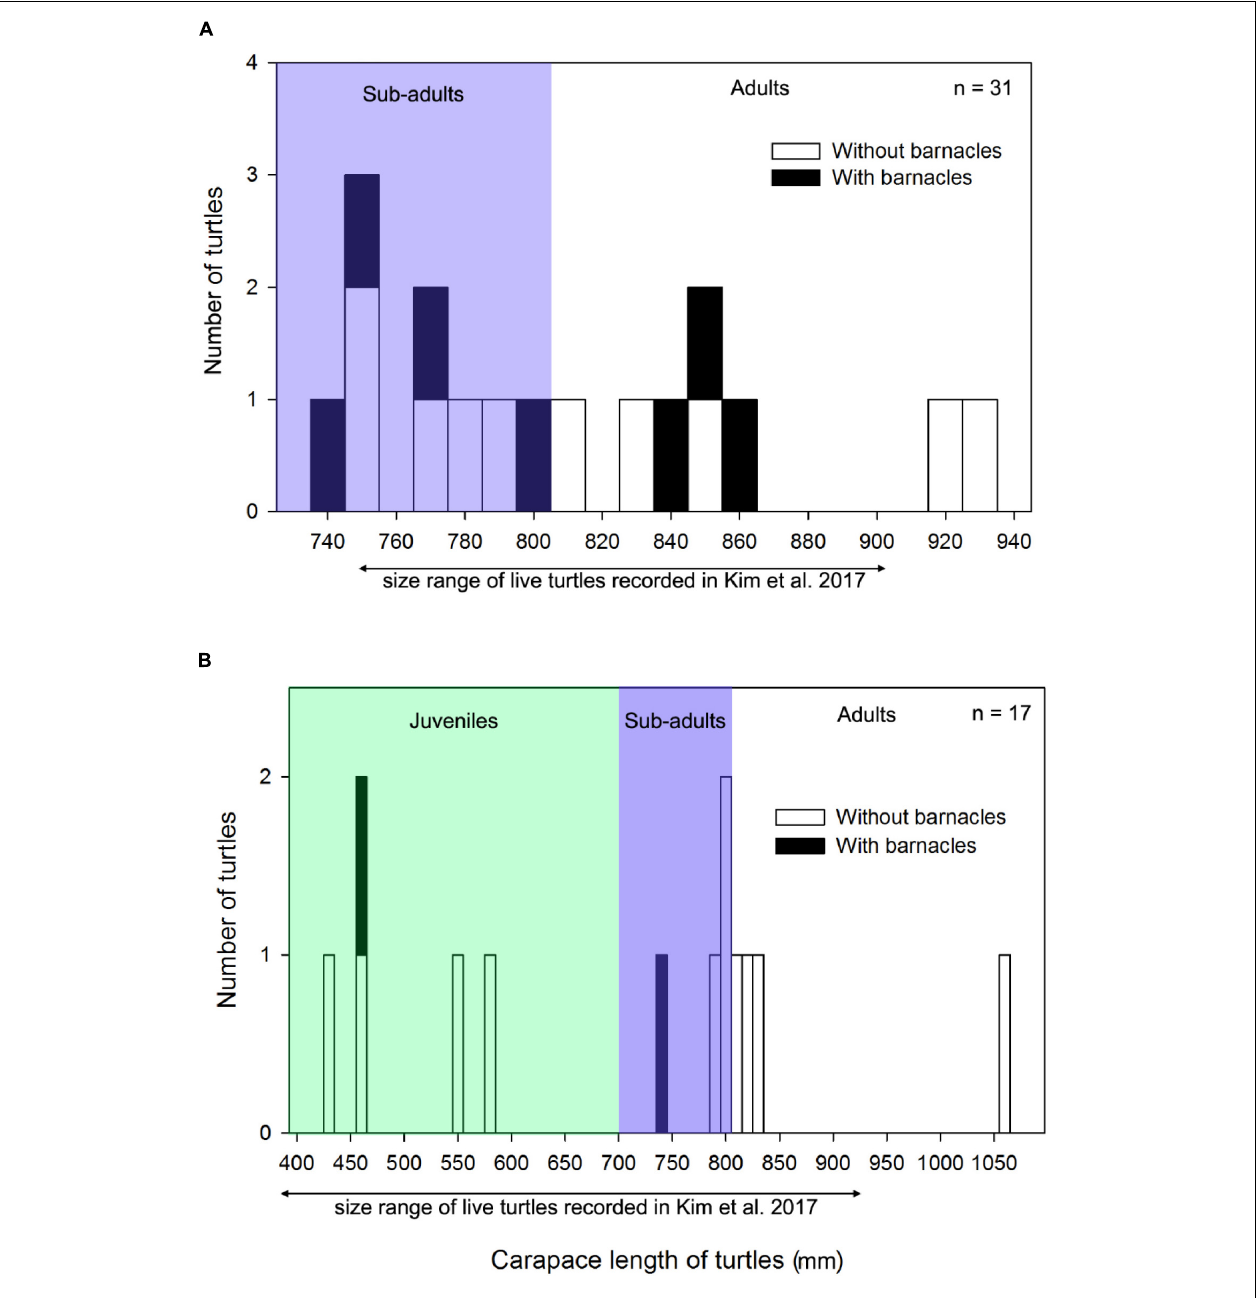
FIGURE 3 | Frequency histograms of carapace length (mm) of (A) Loggerhead sea turtles and (B) Green sea turtles, with (black bars) and without (white bars) barnacles in Korea. The size range of live loggerhead and green sea turtles recorded in Korea in the study by Kim et al. (2017) is provided for comparison with the stranded turtles in this study. The definition of juveniles, subadults, and adults is based on the size range defined in the study by Hughes (1974).